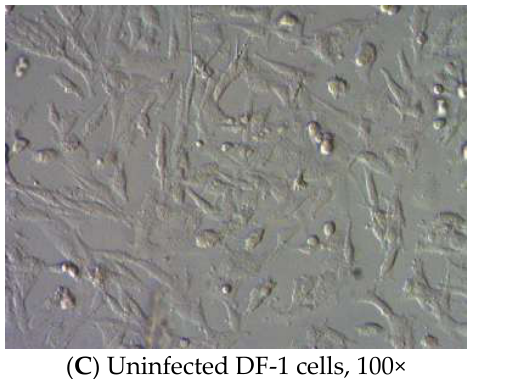
Table 1. Virus inhibition assay of the viruses incubated with GO or GO-Ag. mg/mL